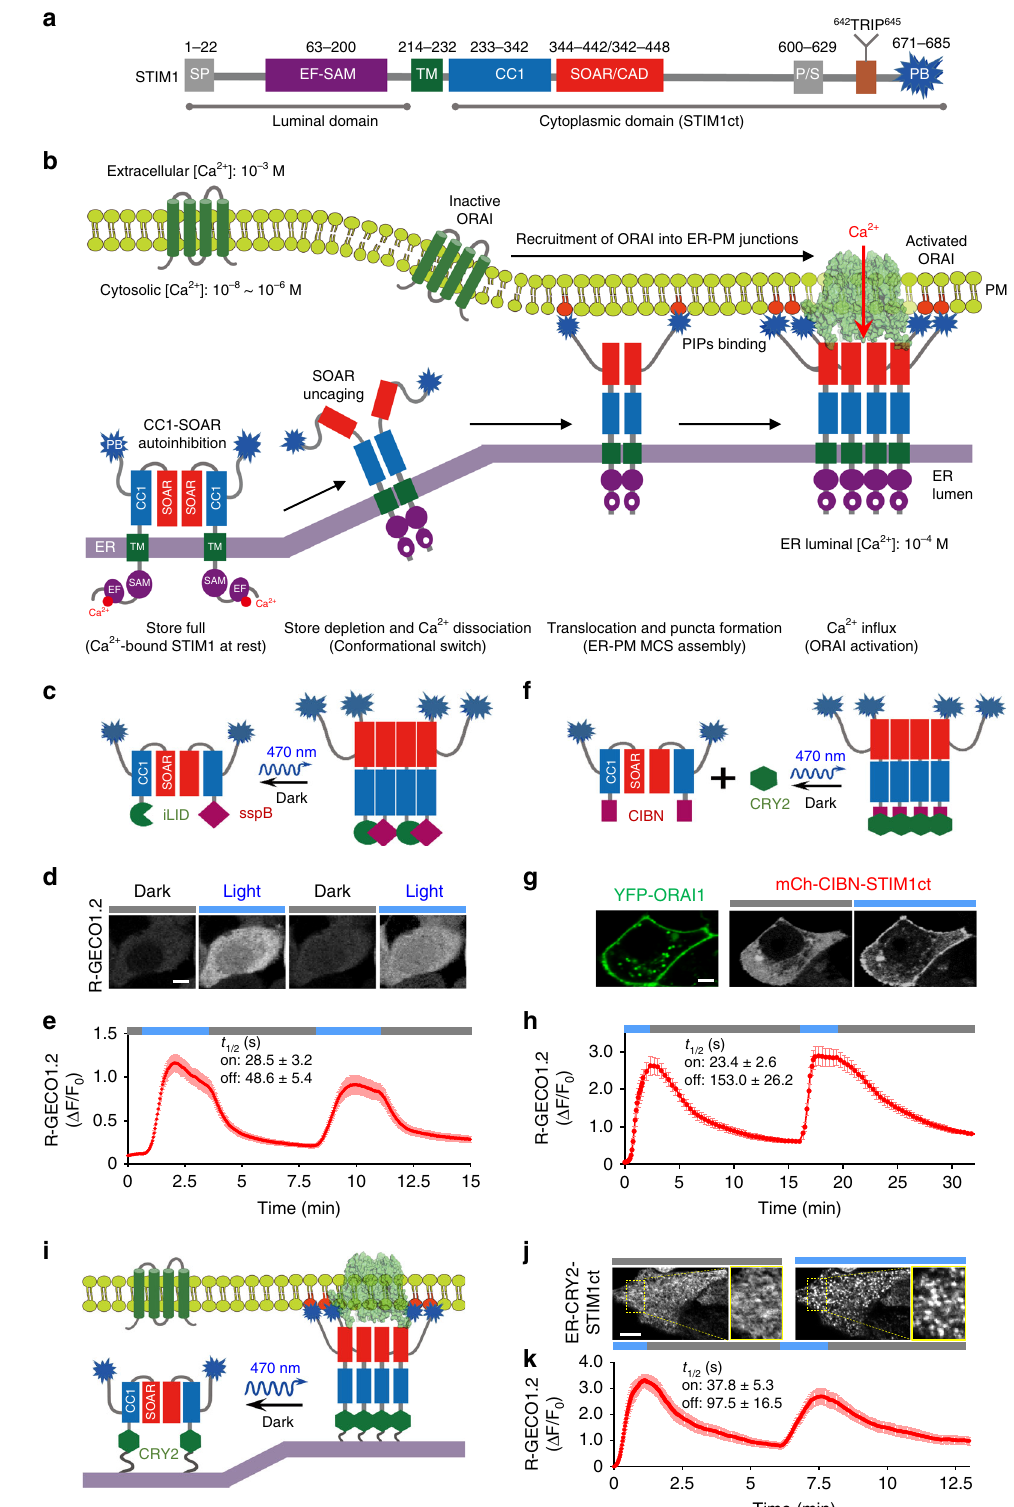
light stimulation (Supplementary Fig. 3b). Together, light- induced close apposition of the N-terminus of STIM1ct (in the CC1 region), much like store depletion-induced oligomerization of the luminal domain and TM re-organization, is suf fi cient to trigger STIM1 activation with ultimate Ca 2 + in fl ux through ORAI channels. Furthermore, upon the withdrawal of